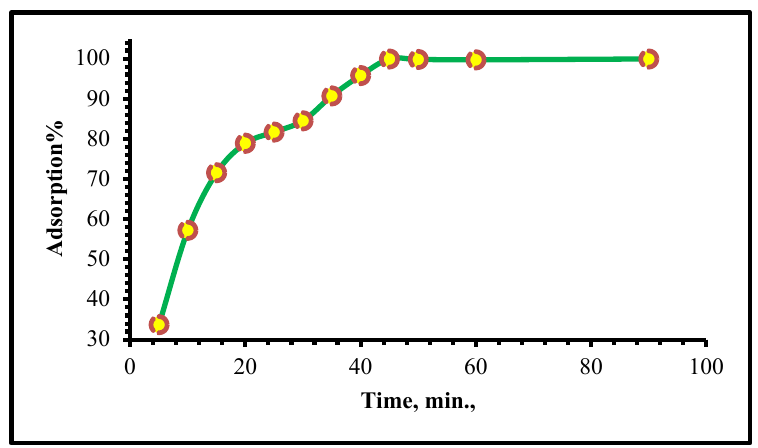
Figure 7. Influence of contact time upon the Cr(VI) adsorption using TIHP. [Cr(VI)] = 250 mg/L, TIHP dose = 0.08 g, pH = 2, T = 25 ± 1 °C.